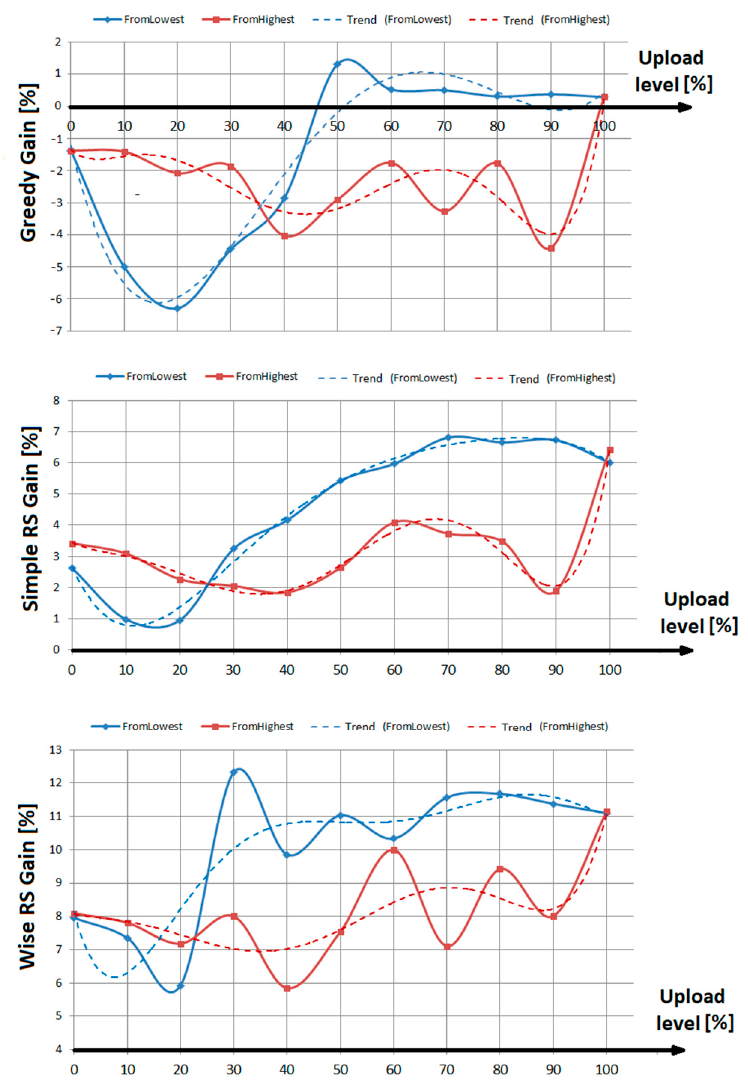
Figure 5. Evolution of cost reduction in case dynamic matrix upload (starting from highest and lowest matrix values, respectively).